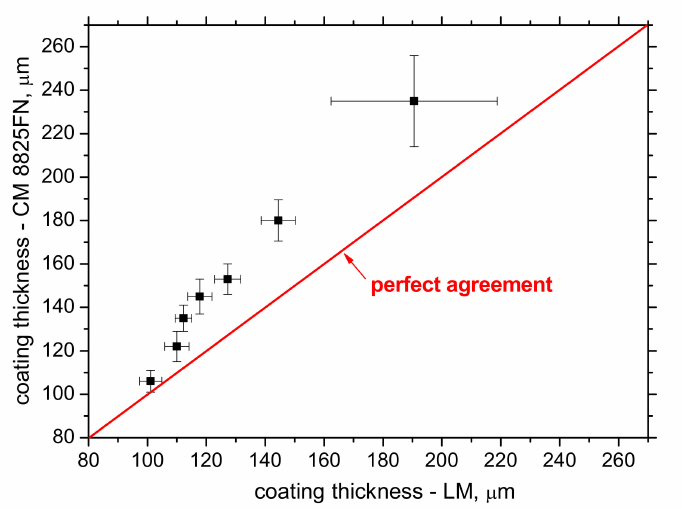
Figure 5. Correlation between coating thickness obtained from LM and measured by CM-8825FN.